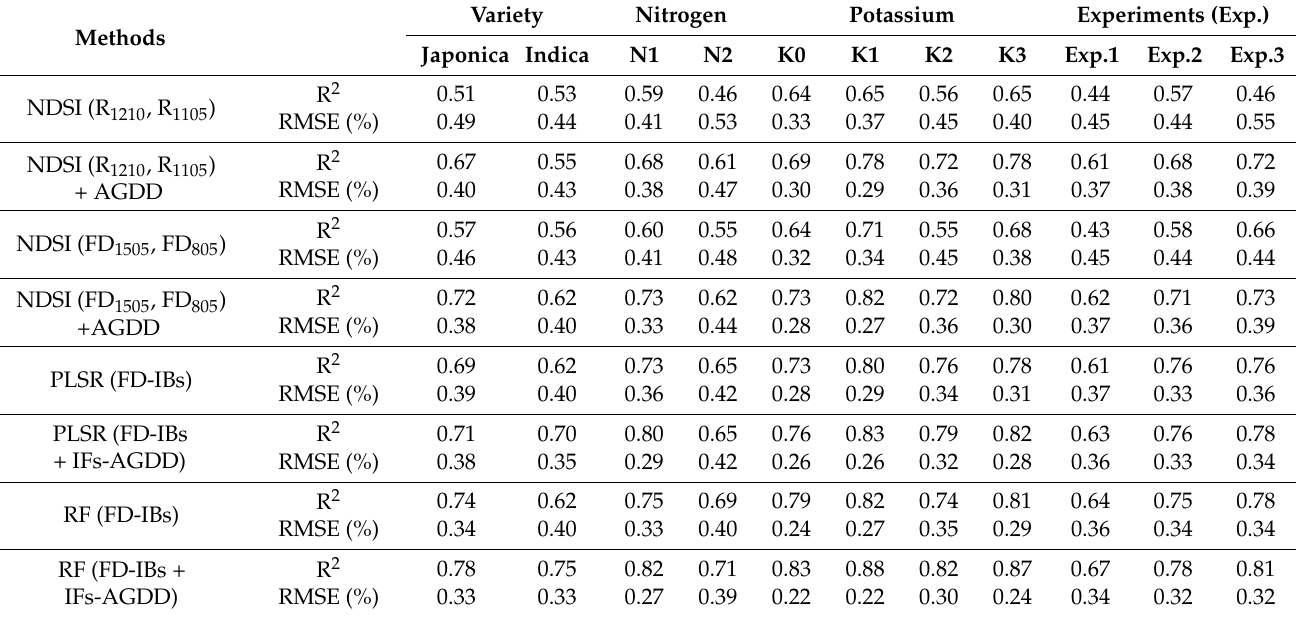
Table 8. Correlations between rice plant potassium content (PKC) and different remote sensing methods under the different datasets. Methods